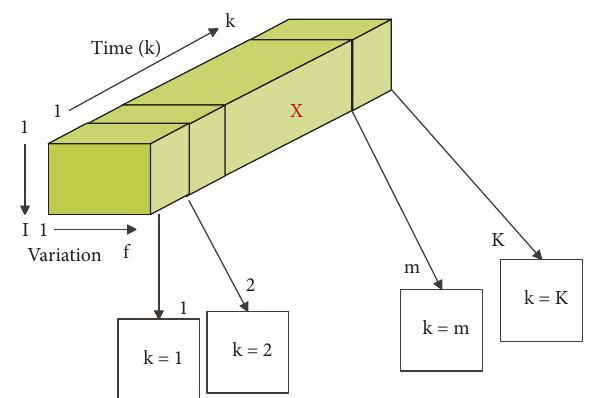
Figure 9: Schematic diagram of time slice cutting of the three- dimensional